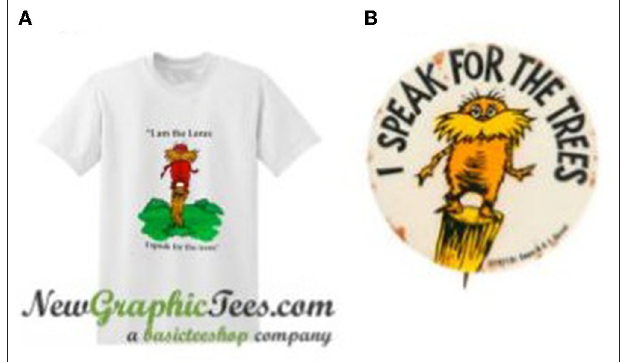
FIGURE 3 | The Lorax paraphernalia. (A) T-shirt design with the Lorax (https:// newgraphictees.com/product/i-am-the-lorax-i-speak-for-the-trees-t-shirt/) 1 . (B) I speak for the trees button (https://www.hakes.com/Auction/ItemDetail/ 79599/DR-SEUSS-DESIGNED-RARE-I-SPEAK-FOR-THE-TREES- ECOLOGY-THEMED-BUTTON-FEATURING-THE-LORAX) 2 .